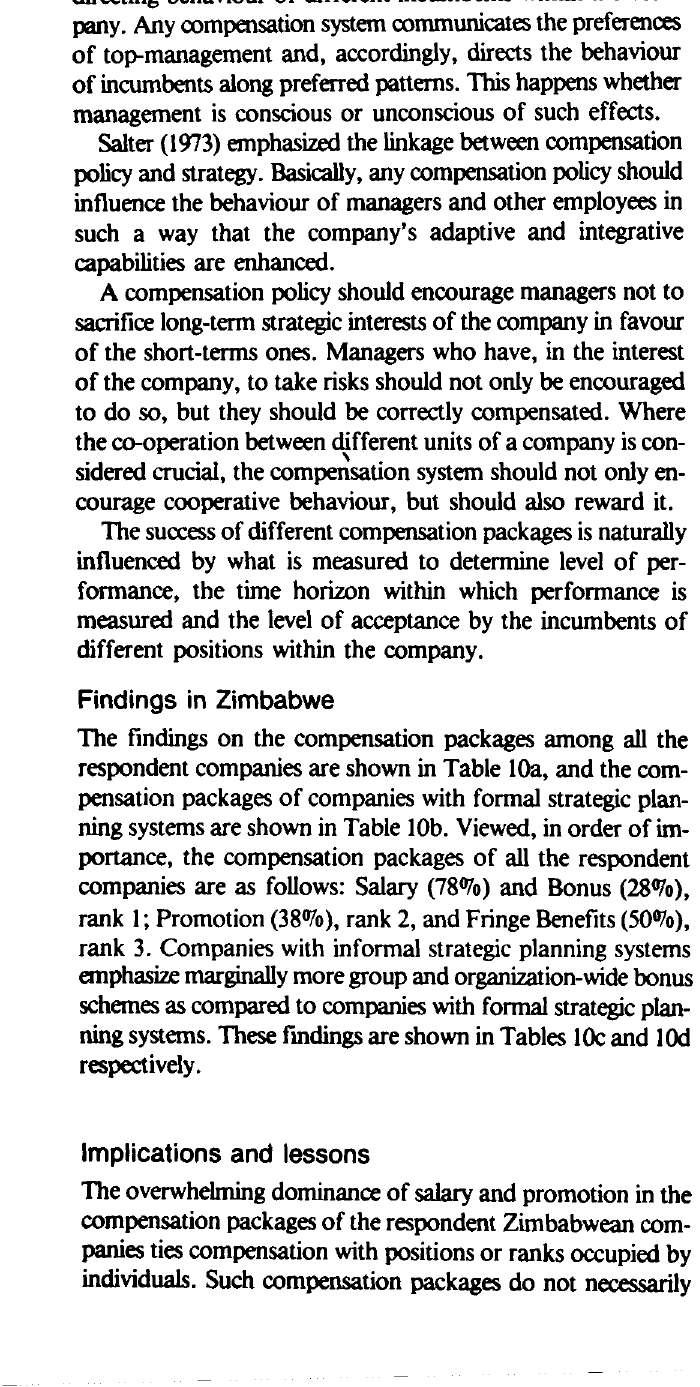
Table 10c Levels of bonus schemes (All respondent